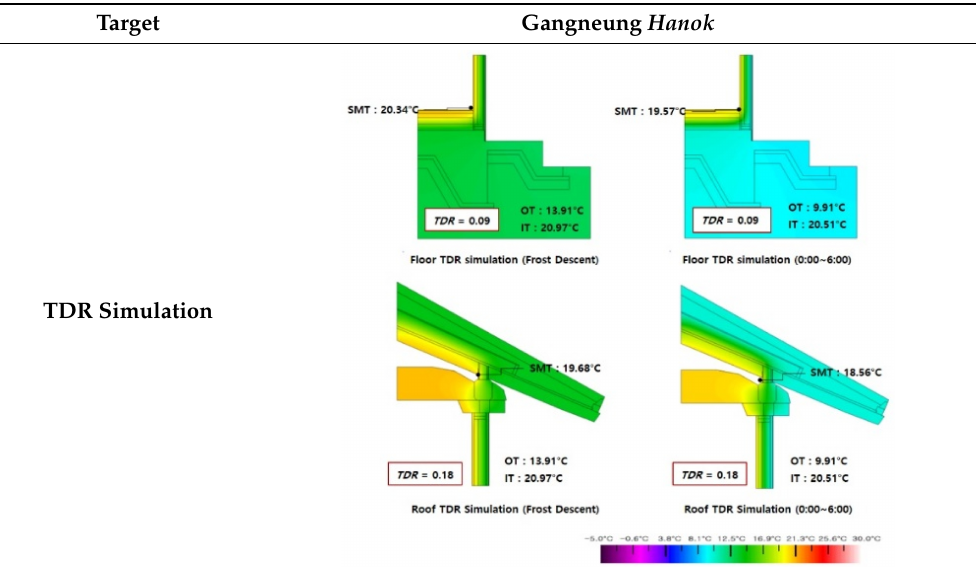
Table 10. Temperature difference ratio (TDR) simulation of wall